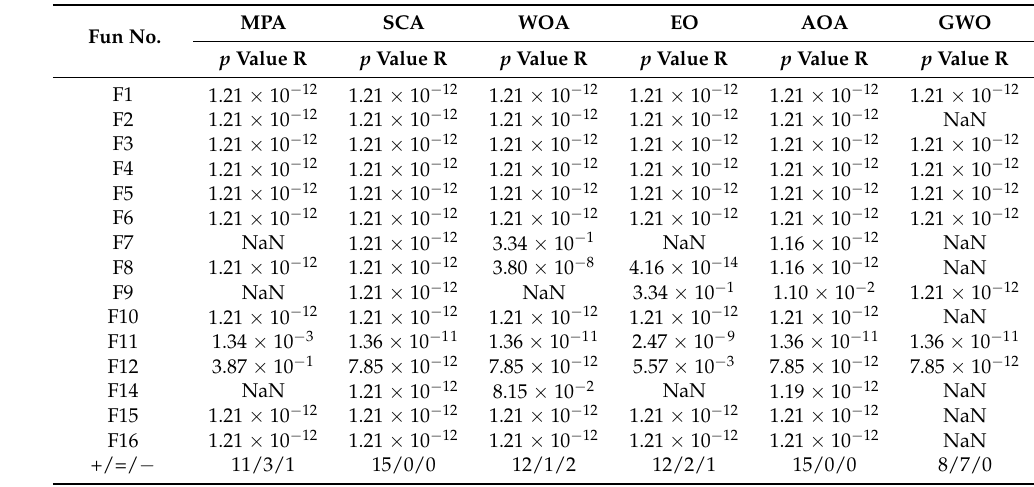
Table 5. Wilcoxon rank sum test results.